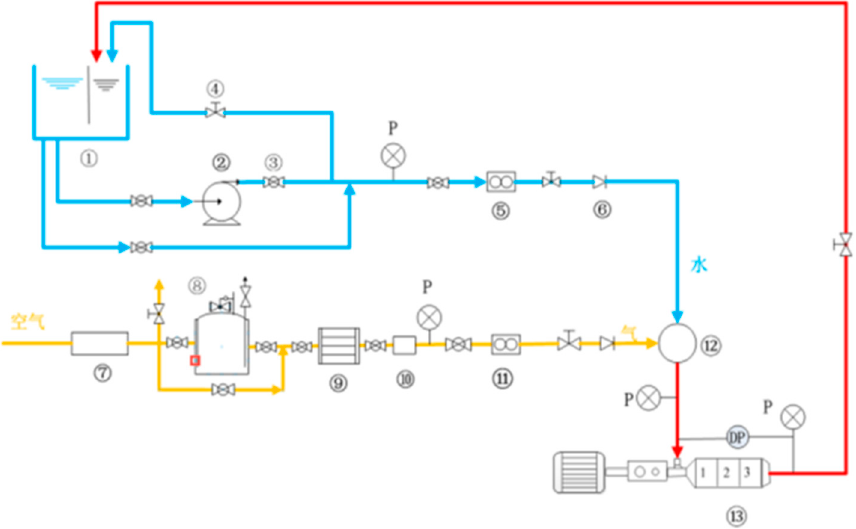
Figure 5. Experimental system schematic diagram of the multiphase pump. Labels: